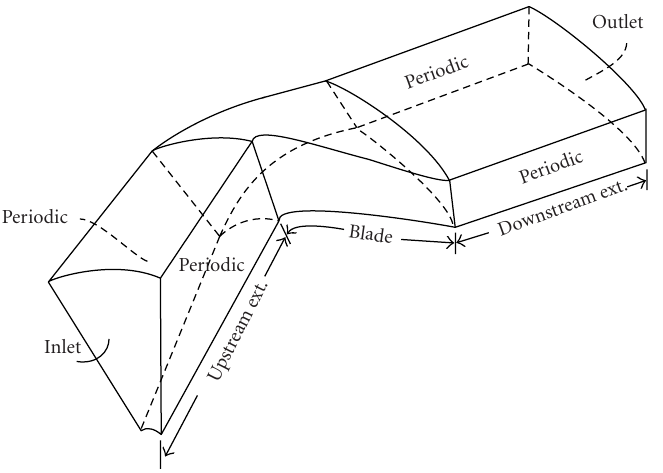
Figure 2: Solution